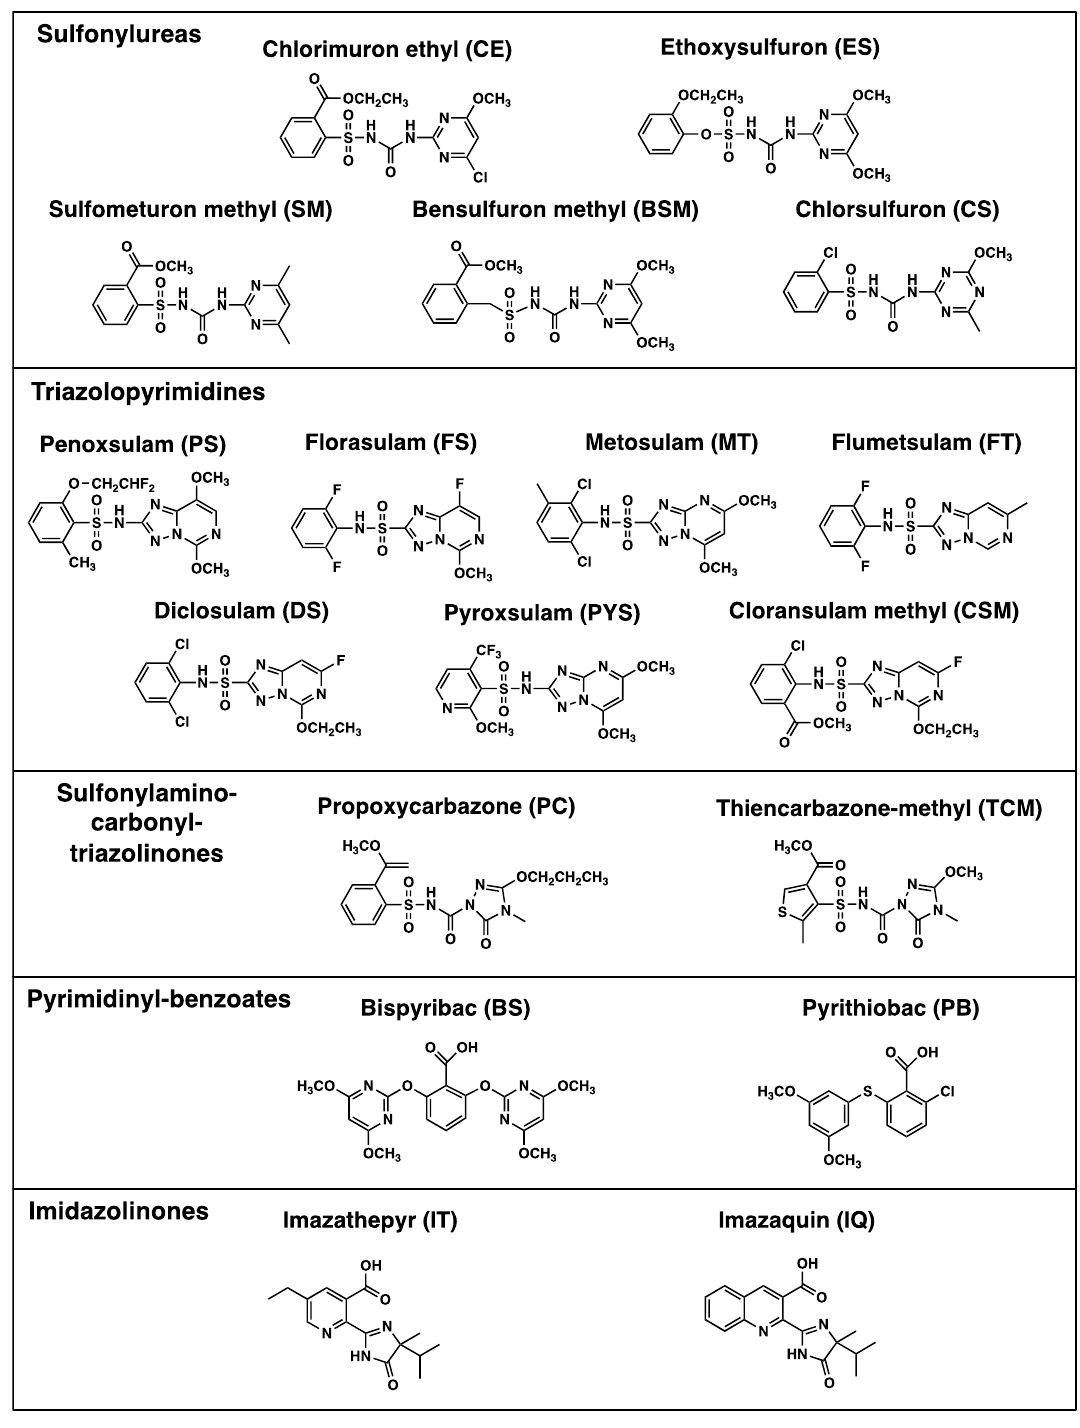
Figure 1. Chemical structures of the commercial herbicides evaluated here. A general feature of the sulfonylureas, triazolopyrimidines, and sulfonylamino-carbonyl-triazolinones is the presence of both an aromatic and a heterocyclic ring. The structural images were created using CHEMDRAW